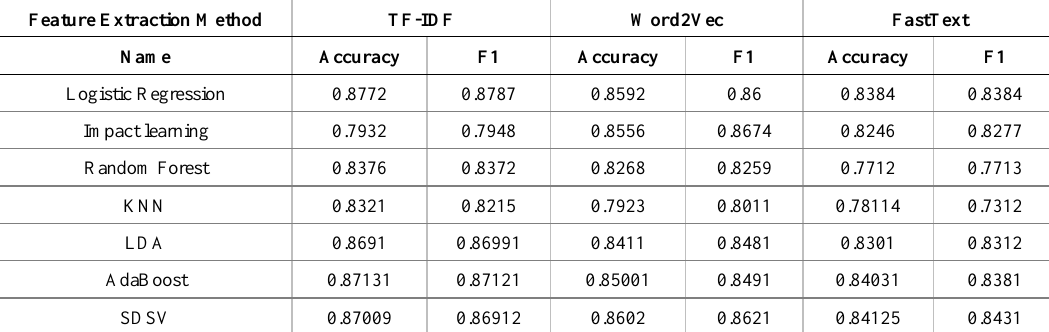
Table 1. Binary classification result: IMDB Dataset of 50K Movie Reviews.